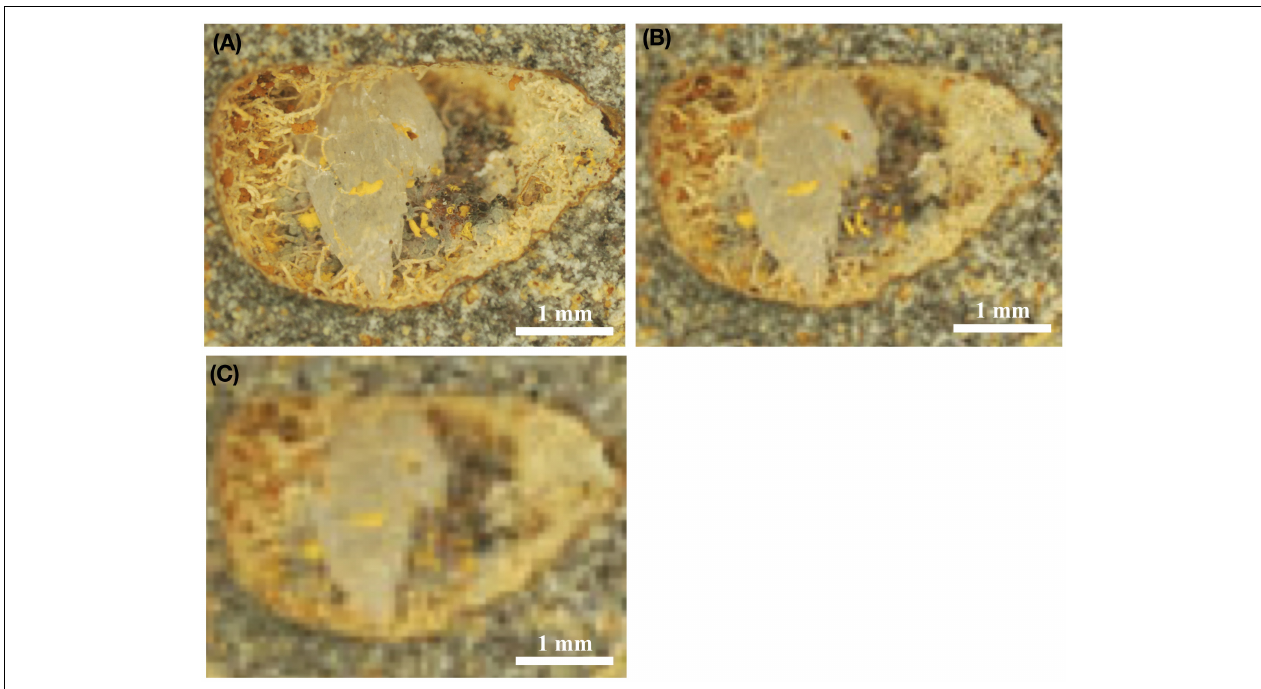
FIGURE 5 | Stereomicroscopic images of fossilized fungal mycelia in a subseafloor basalt-vesicle (A–C) . ODP sample 197-1206A- 4R-2, 0, from Koko Seamount. Panel (A) shows the original, high resolution, stereomicroscopic image, and Panel (B) shows how the same image would look with a resolution of 8 µ m/pixel, which is the highest possible resolution by ESA’s ExoMars 2020 mission. In turn, (C) illustrates how this image would look using the optical resolution of 16 µ m/pixel, which represent the possible resolution using NASAs’s Mars 2020 mission equipment. Panels (B,C) thus represents purposefully pixelated images of (A) to show how the same sample would look, with either the cameras used by ExoMars 2020 (B) or NASA Mars 2020 missions (C)